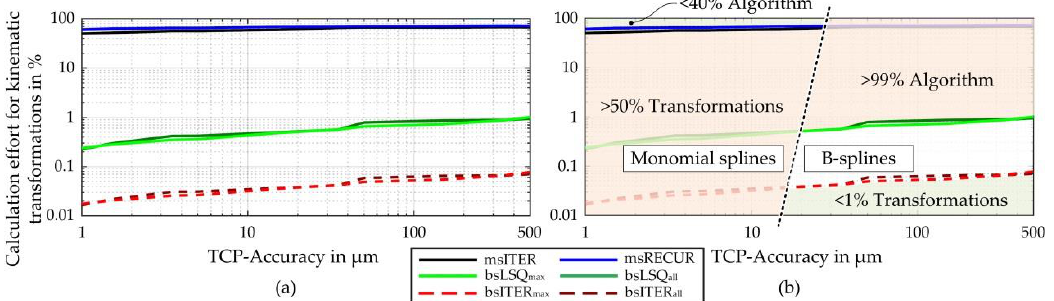
Figure 8. Percentage of computational effort for kinematic transformations in relation to the total computational effort. ( a ) Results for all algorithms. ( b ) Comparison of monomial splines (left) and B-splines (right) .